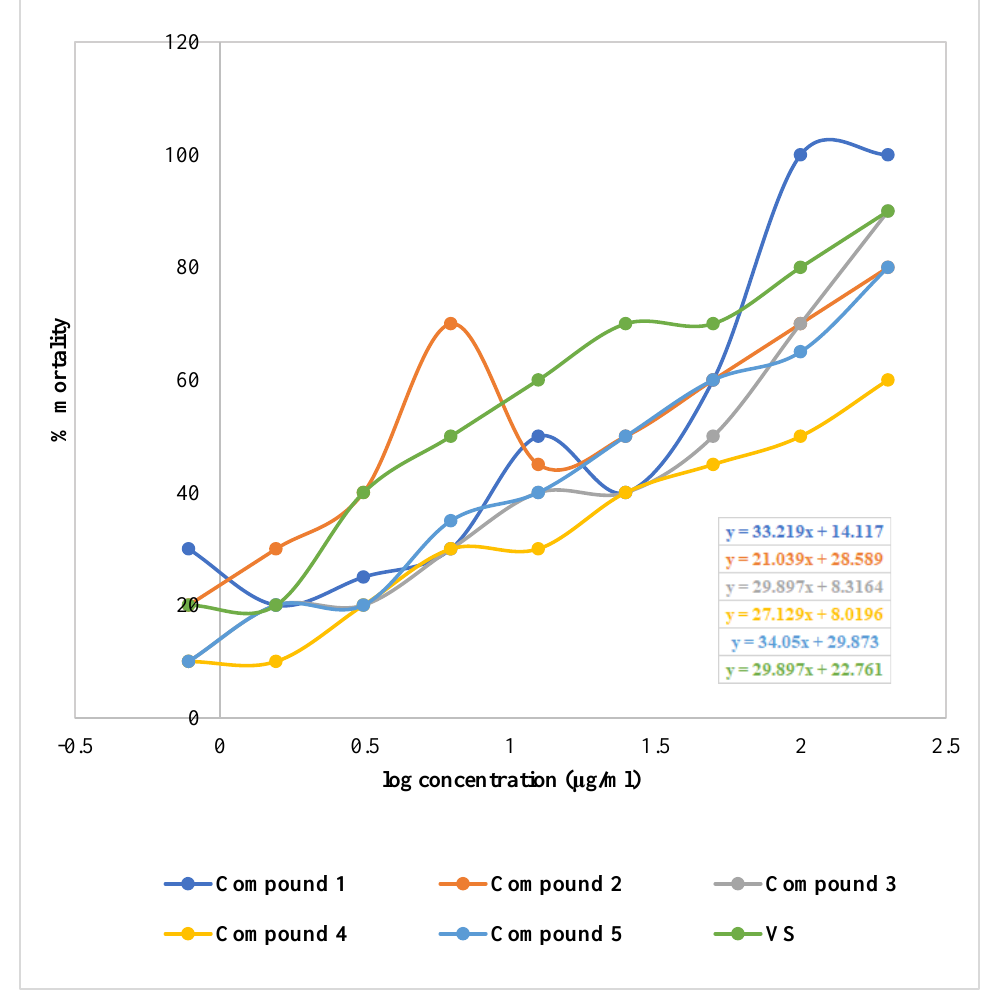
Figure 5. Linear regression equations (LC 50 ) of Vincristine Sulphate (VS) and isolated phytochemicals of Glycosmis cyanocarpa.